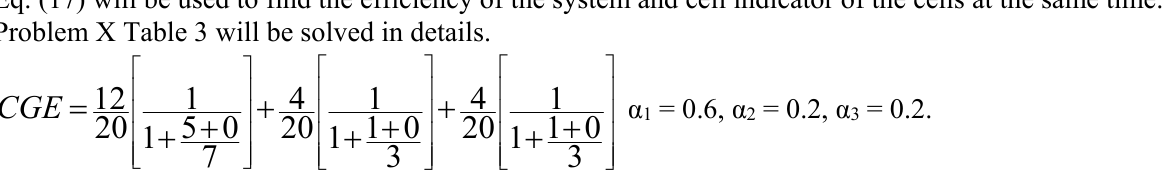
Efficiency of the system and Cell indicator using CGE for problem 1